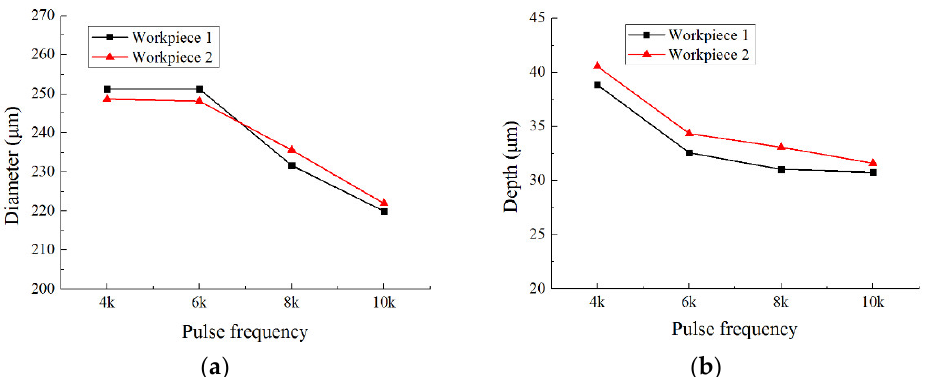
Figure 10. The effect of pulse frequency on the dimension of micro dimples. ( a ) diameter; ( b ) depth.